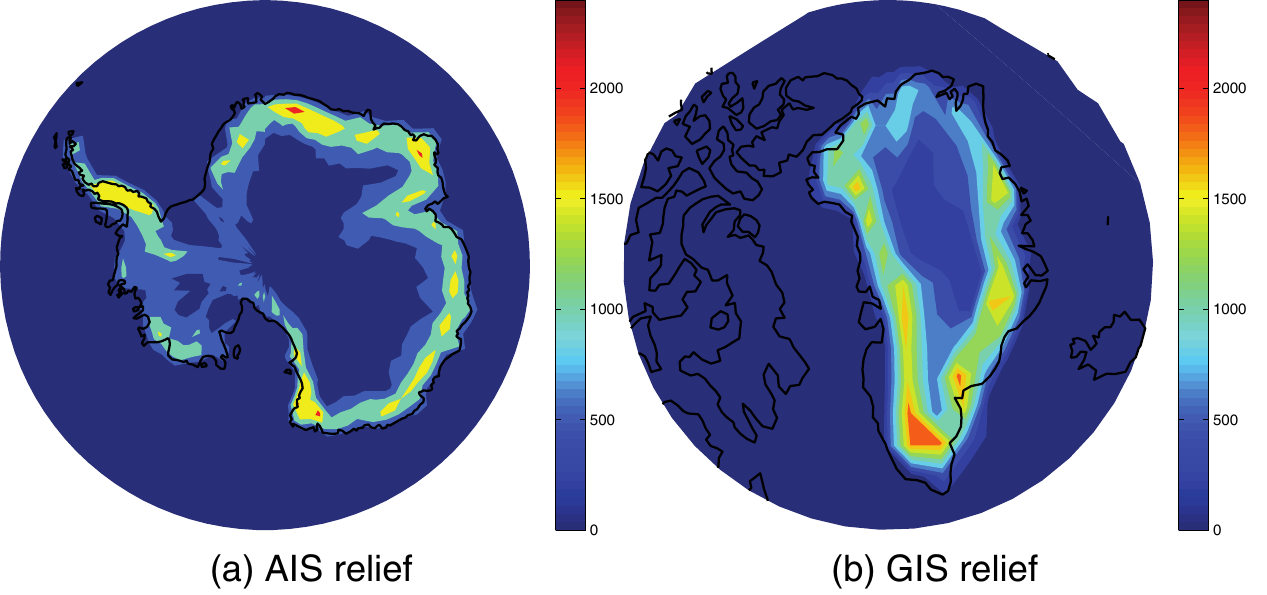
Fig. 1. Total relief used to determine number of elevation bins in each climate model grid cell (m) for the Antarctic Ice Sheet (AIS) and Greenland Ice Sheet (GIS), where total relief is the maximum elevation minus the minimum elevation existing in the ice sheet grid cells contained within the boundaries of a UVic ESCM grid cell.